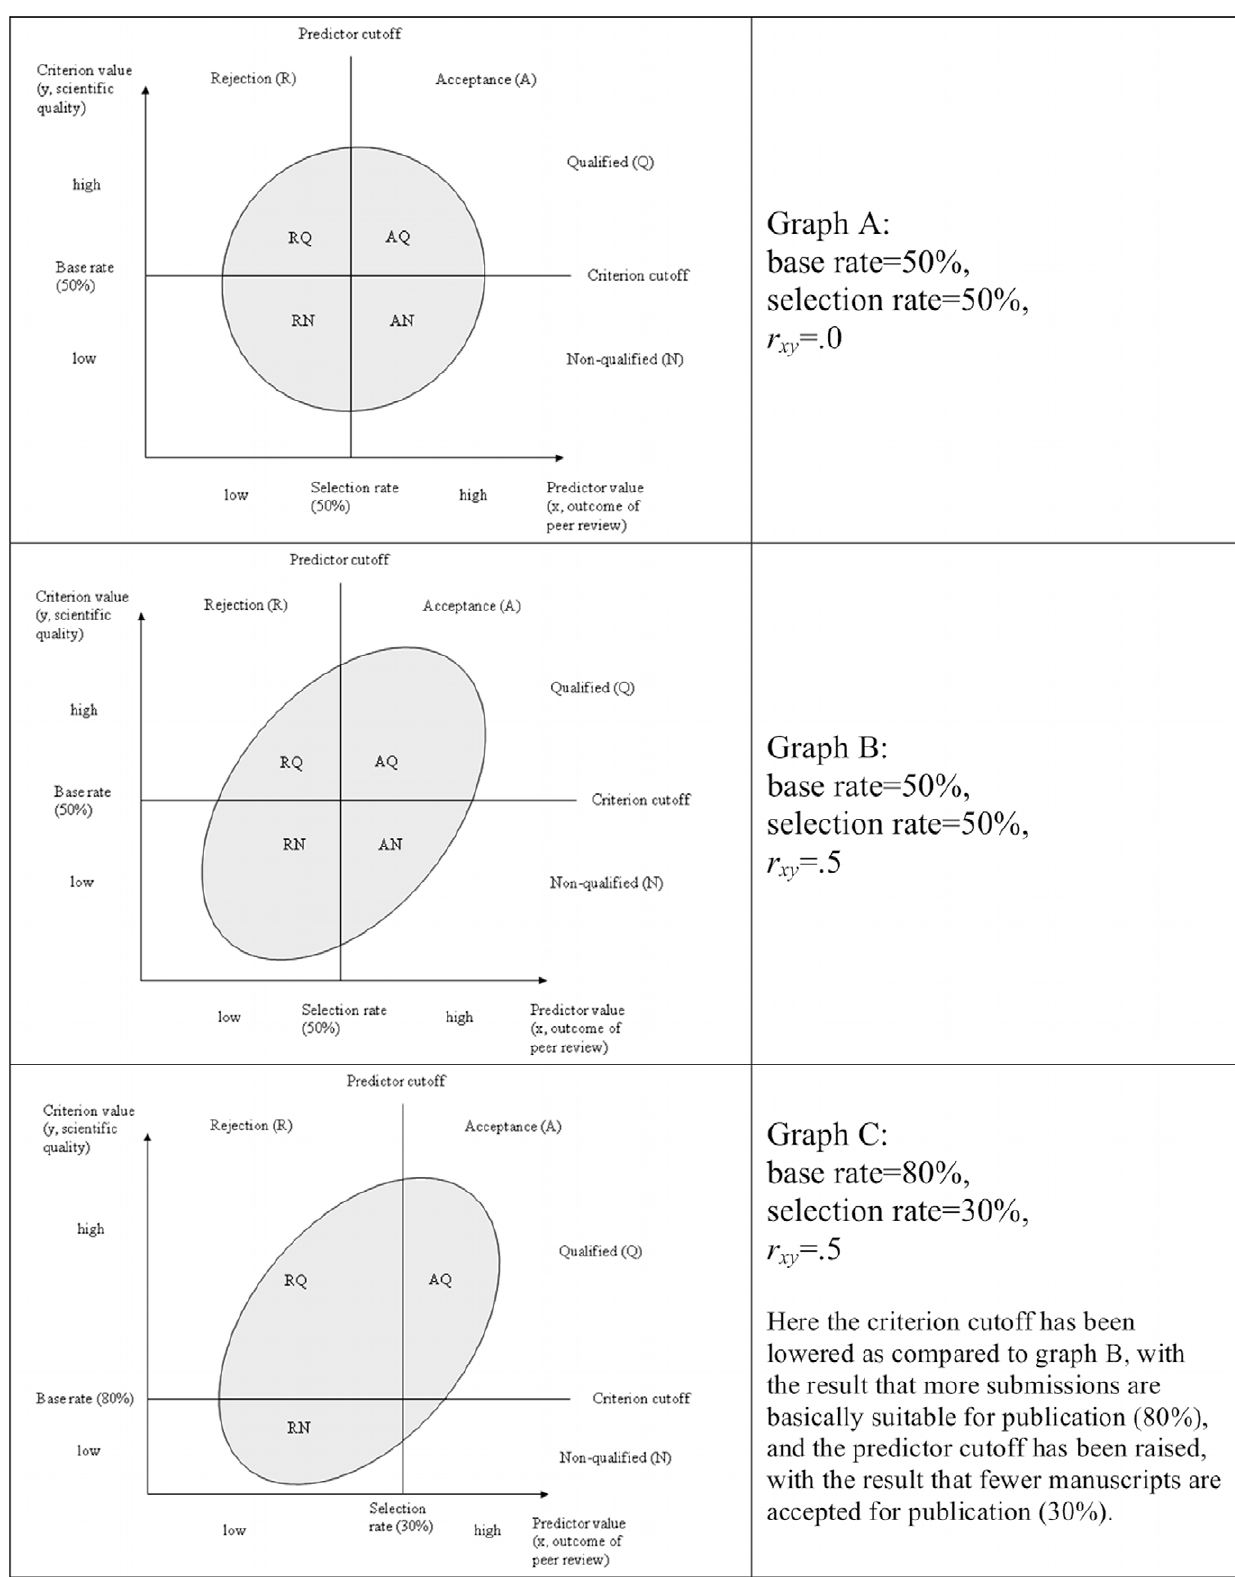
Figure 1. Dependency of the number of accepted and qualified submissions (AQ) on base rate, selection rate and validity coefficient ( r xy ).